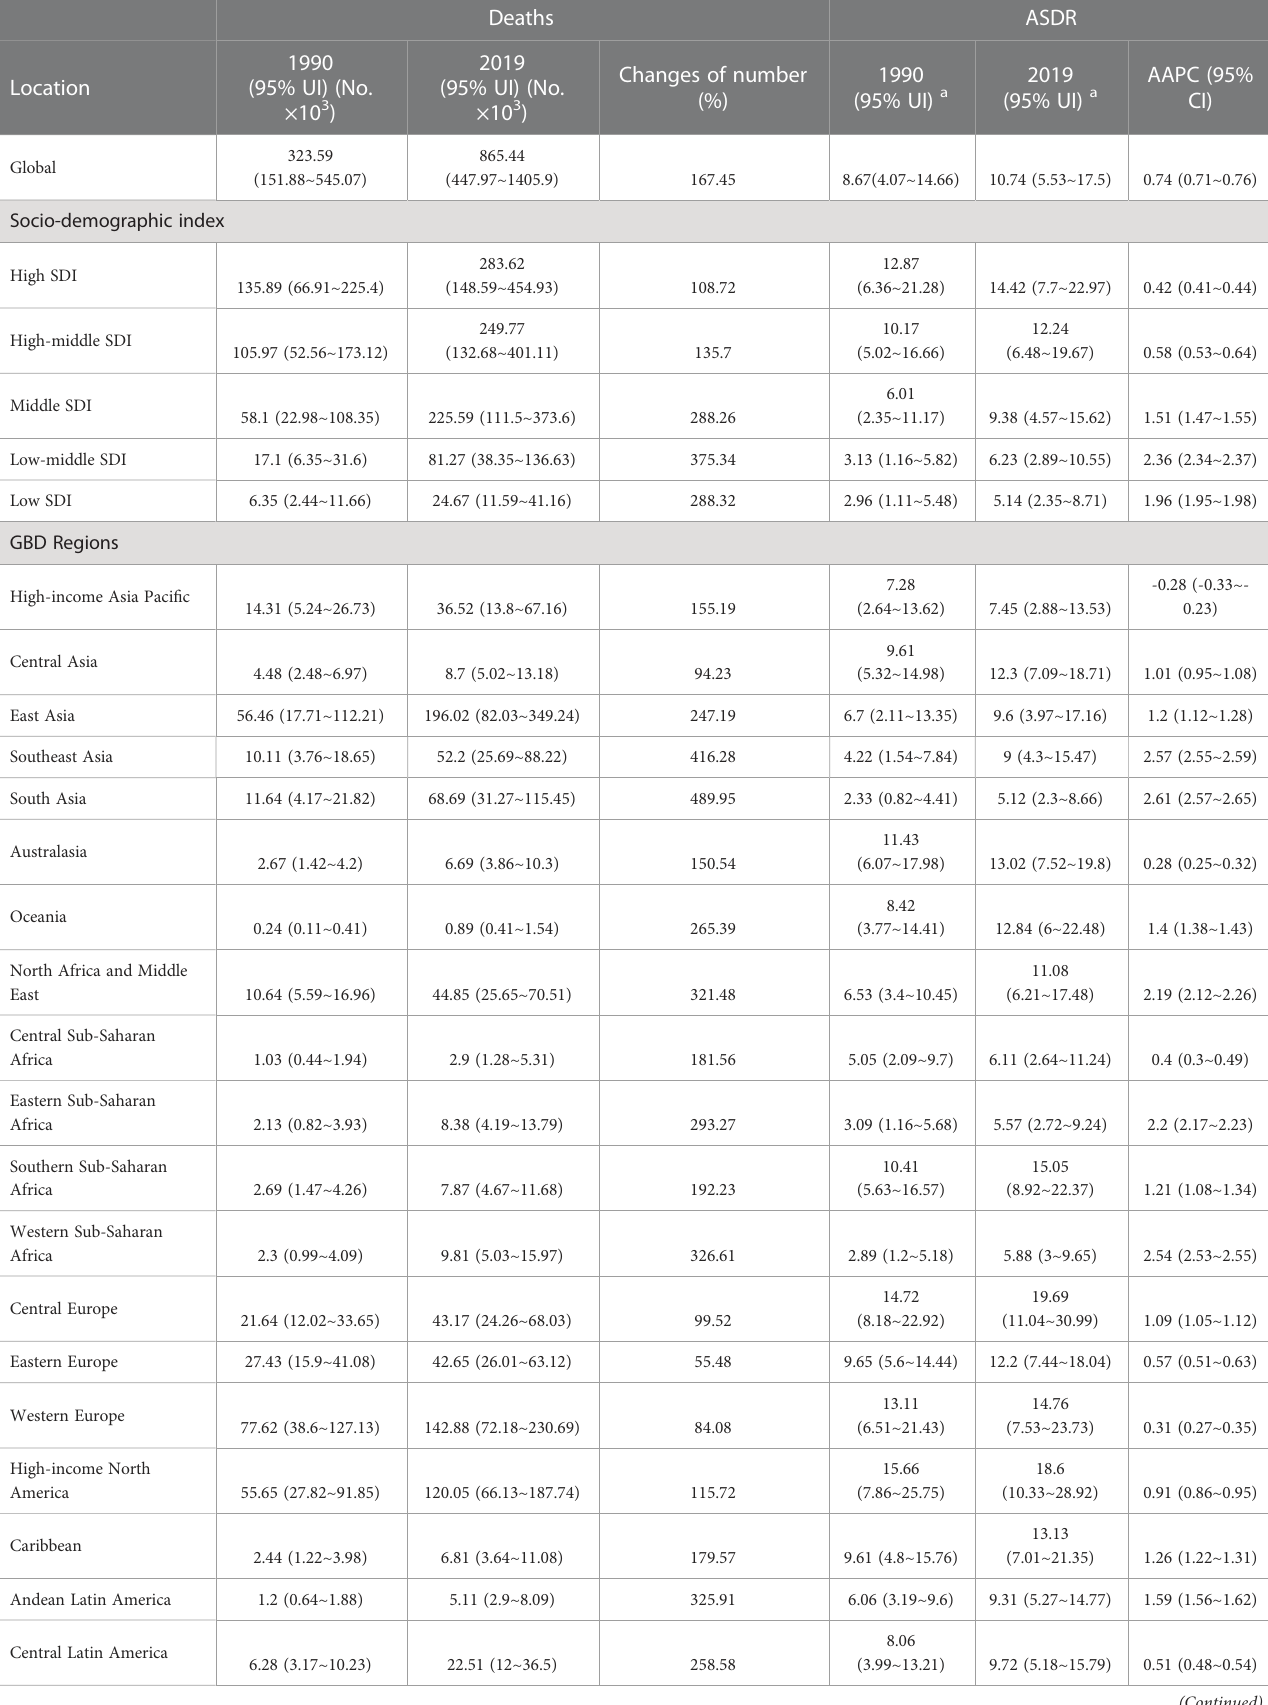
TABLE 1 The death cases, ASDR of cancers attributable to metabolic factors in 1990 and 2019, and their variations from 1990 to 2019.